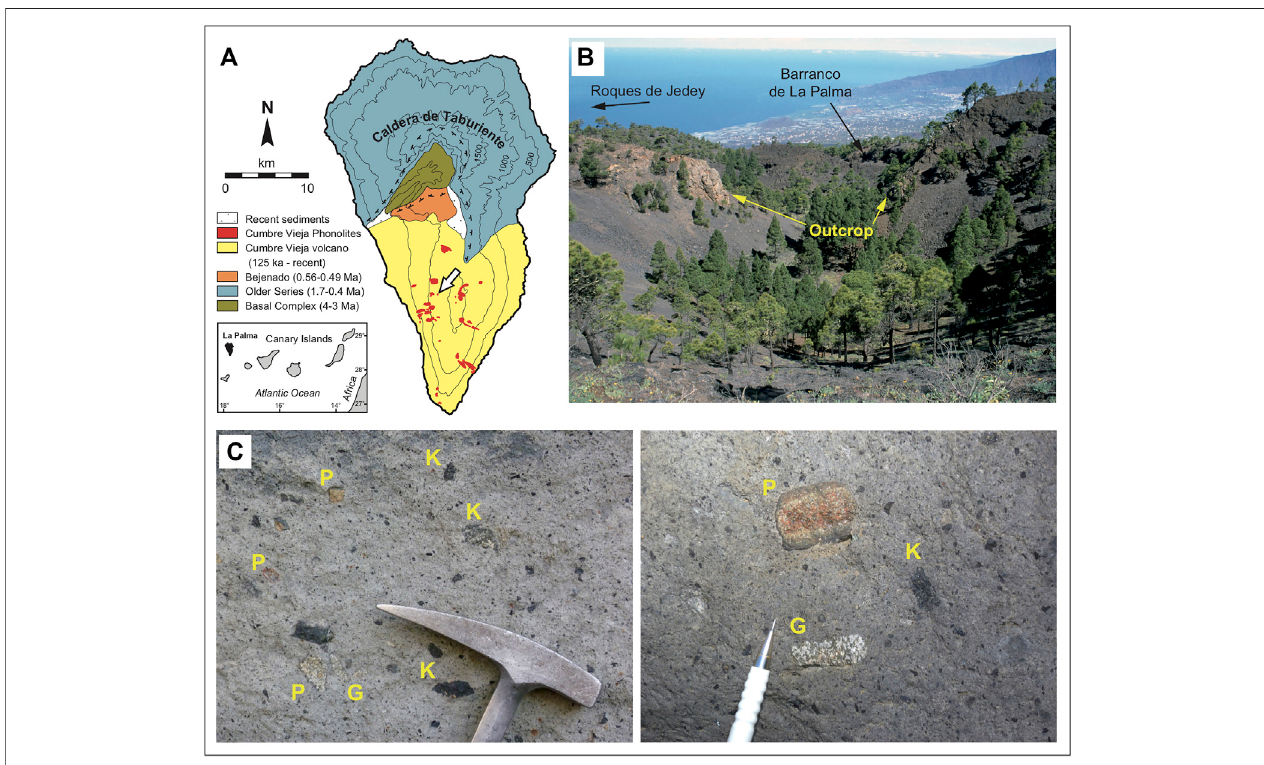
FIGURE 1 | (A) Simpli fi ed geological map of La Palma with arrow showing the locality of the tephriphonolite outcrops. (B) Photograph towards the northwest, showing the breached 1585 eruption crater with the tephriphonolite outcrops (arrows). (C) Outcrop photographs of the tephriphonolite with kaersutitite (K), gabbro (G), and peridotite (P) xenoliths. Note the selvage around the